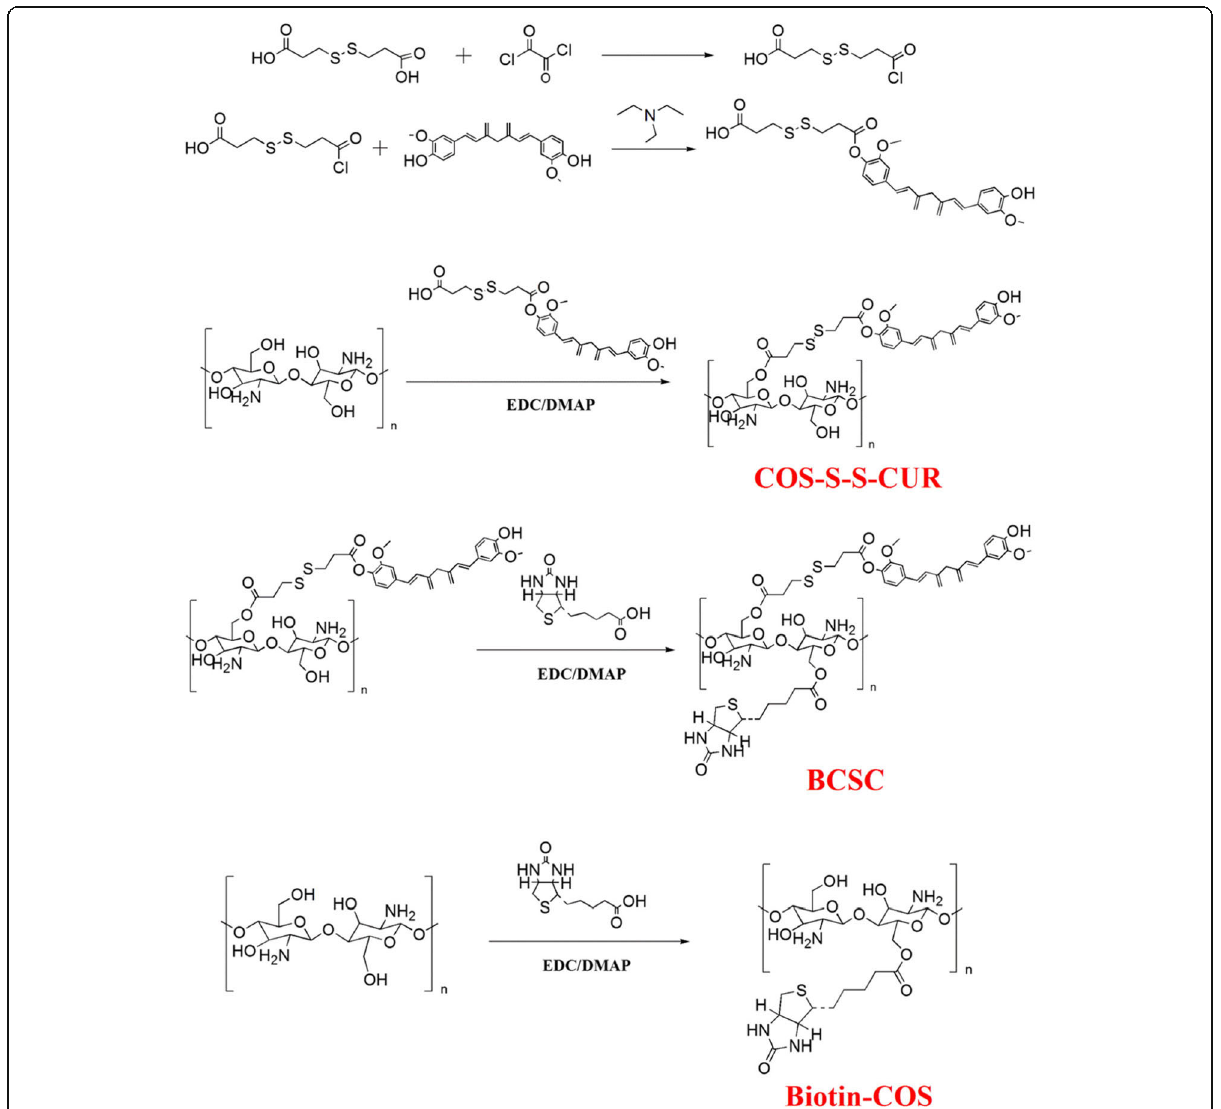
Fig. 2 Synthetic route of COS-S-S-CUR, BCSC, and